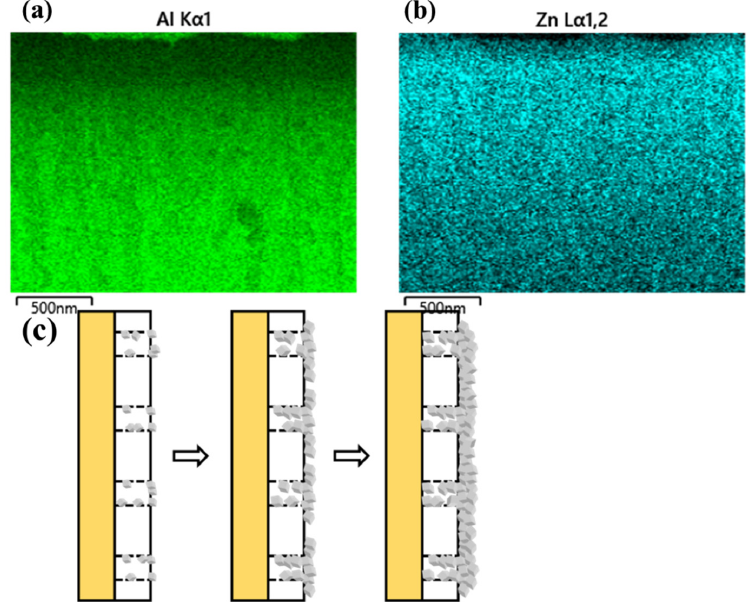
Figure 11. ( a , b ) Mapping characterization results of ZIF-8/AAO membrane prepared with deposition time of 60 min and current of 0.65 mA/cm2. ( c ) Schematic diagram of the evolution of the ZIF-8 membrane structure during formation.